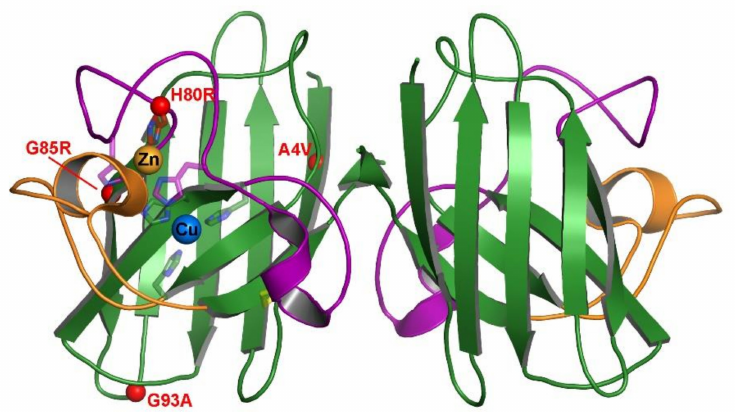
Figure 1. Position of select fALS mutations on mature hSod1. The crystal structure is of wild-type Sod1 (1PU0) with the β -barrel colored green, the electrostatic loop colored orange and the connecting zinc and disulfide loops colored purple. The metal binding residue sidechains are shown as sticks and the metals are shown in their binding sites as labeled spheres. Each of the 4 fALS mutations are shown as small red spheres at their position within the protein structure for visual